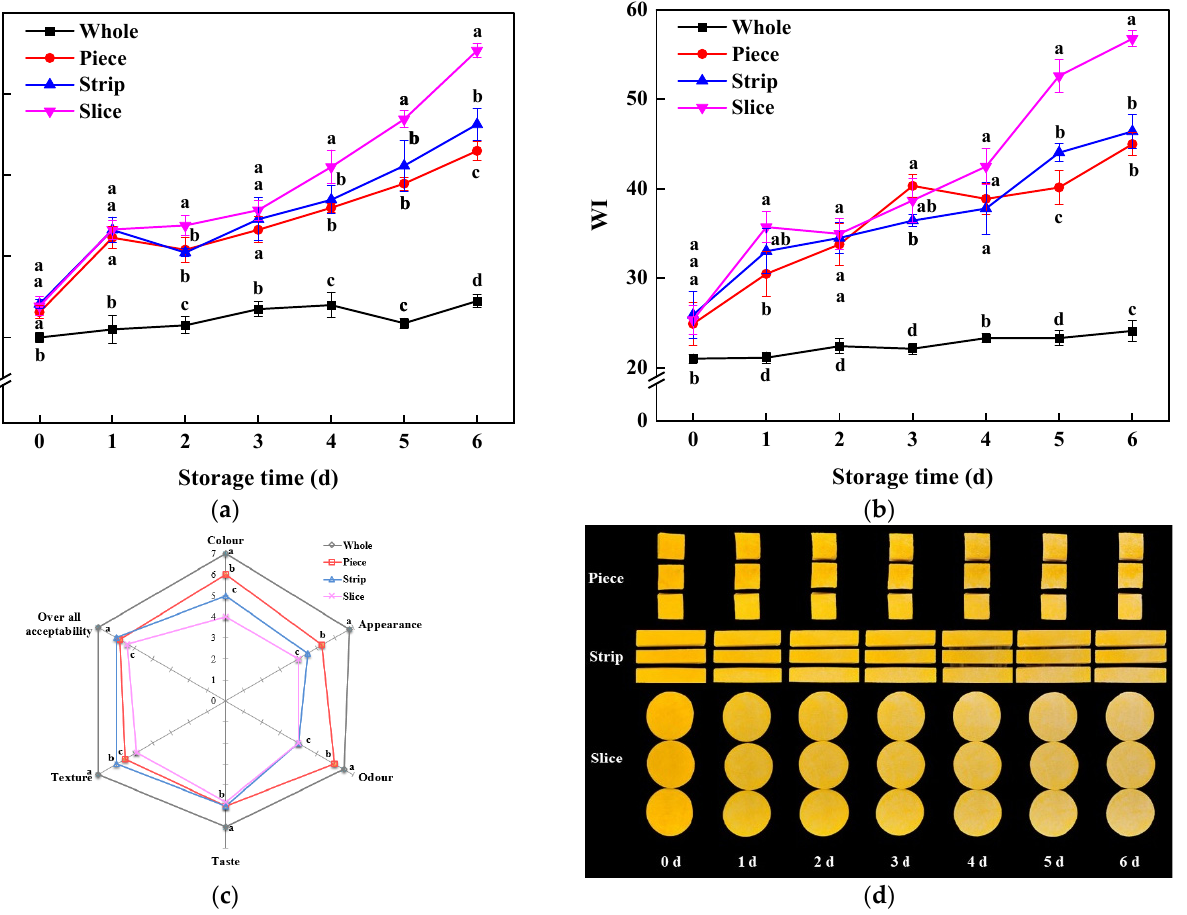
Figure 1. Effect of wounding intensities on lightness ( L *) ( a ), whiteness index (WI) ( b ), sensory evaluation ( c ) and appearance ( d ) of fresh-cut pumpkin during storage at 4 °C for 6 days. Vertical bars represent the standard deviation of the mean (n = 3). Different letters indicate significant differences between the groups ( p <